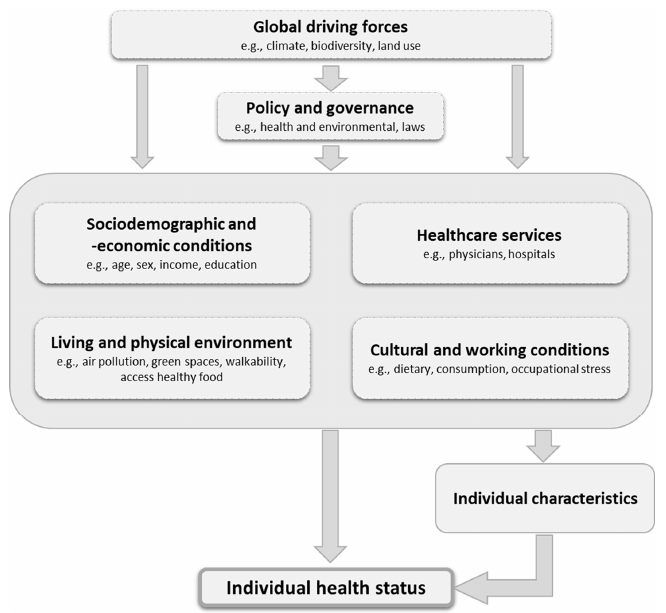
Figure 1. Determinants of